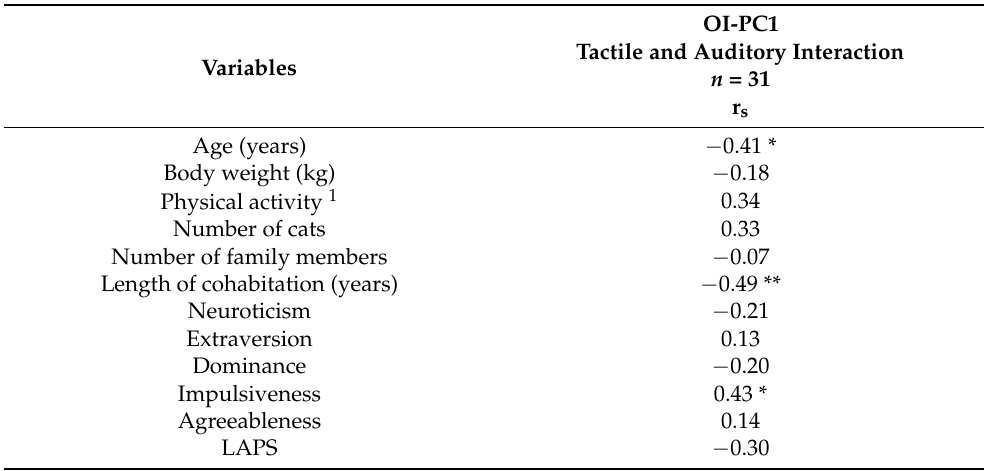
Table 7. Correlations between principal component scores (OI-PC1) and other variables (individual variables, housing environment, cat personality, and owner attachment). OI-PC1 Tactile and Auditory Interaction Variables n = 31 r s Age (years) − 0.41 * Body weight (kg) − 0.18 Physical activity 1 0.34 Number of cats 0.33 Number of family members − 0.07 Length of cohabitation (years) − 0.49 ** Neuroticism − 0.21